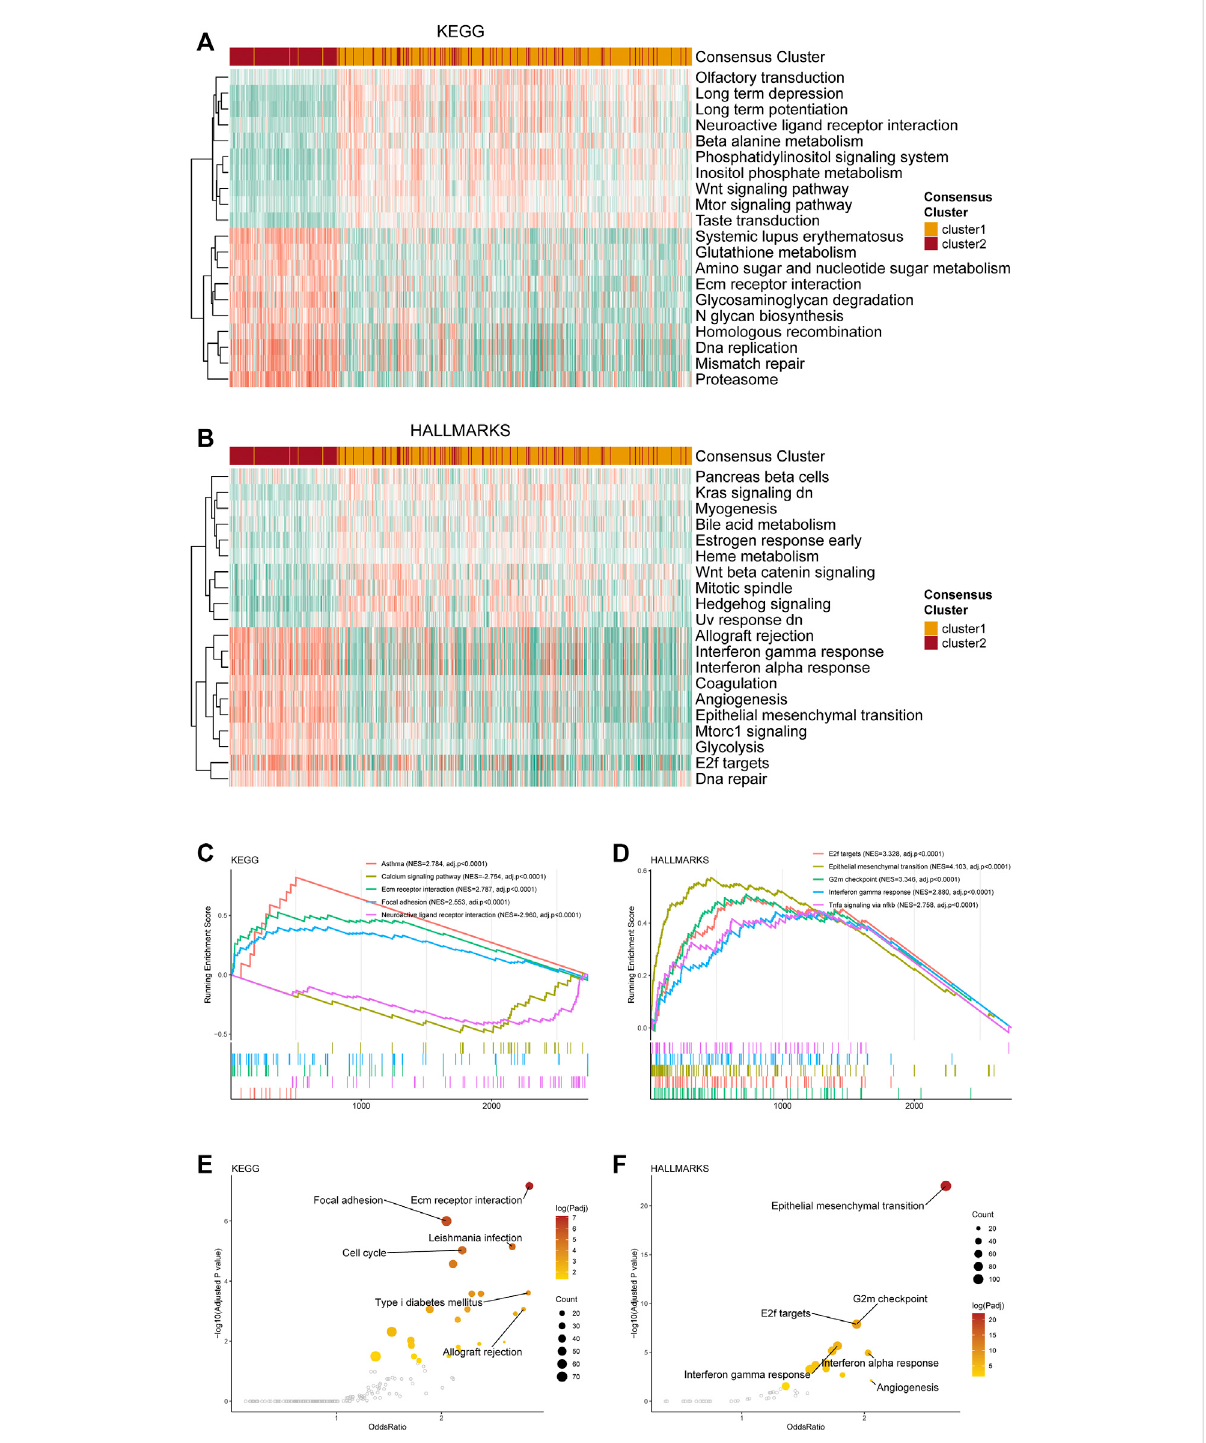
FIGURE 2 Functional enrichment analysis of the transcriptome of the consensus clusters. (A) Top 20 differentially expressed KEGG gene sets. (B) Top 20 differentially expressed HALLMARKS gene sets. (C) The top fi ve pathways with the highest normalized enrichment score in the KEGG gene sets between two clusters. (D) The top fi ve pathways with the highest normalized enrichment score in the HALLMARKS gene sets between two clusters. (E) Pathways with high odds ratio and con fi dence in the KEGG gene sets. (F) Pathways with high odds ratio and con fi dence in the HALLMARKS gene